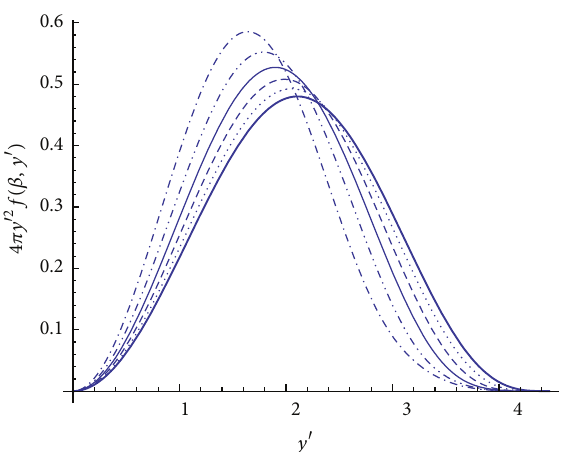
Figure 6: We show the angular average of the properly normalized velocity distribution for values of the asymmetry parameter 𝛽 = (0.0.1, 0.2, 0.3, 0.4, 0.5) . In the plots, 𝛽 is increasing from right to left. The results depend on the value of the potential in our vicinity. Here, the value of 𝜉(𝑥𝑠) = 10 was